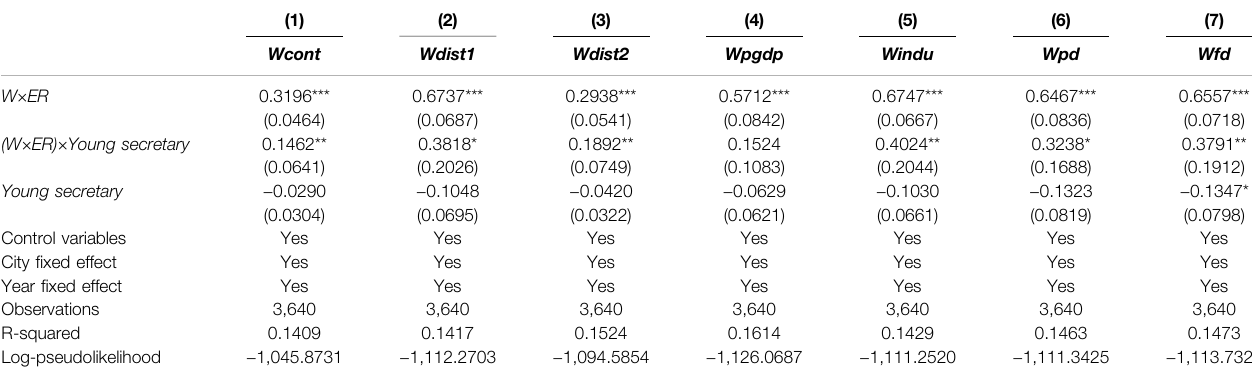
TABLE 12 | Estimates for a young secretary and strategic interactions in environmental